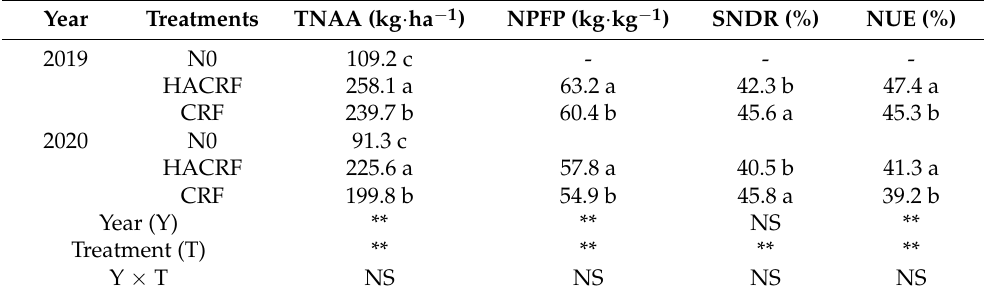
Table 2. Effects of humic acid added to controlled-release fertilizer on nitrogen accumulation and utilization of summer